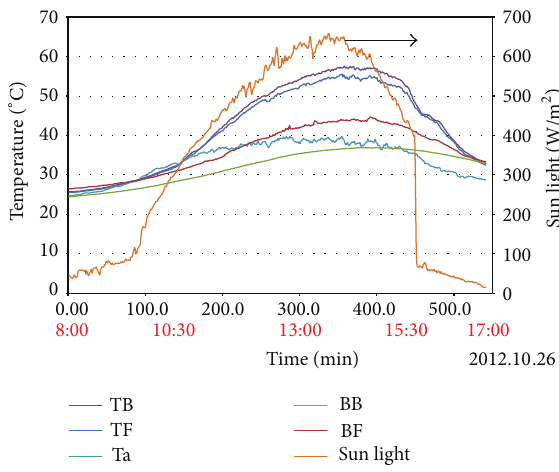
Figure 12: Temperature measurement of the BIPV system.